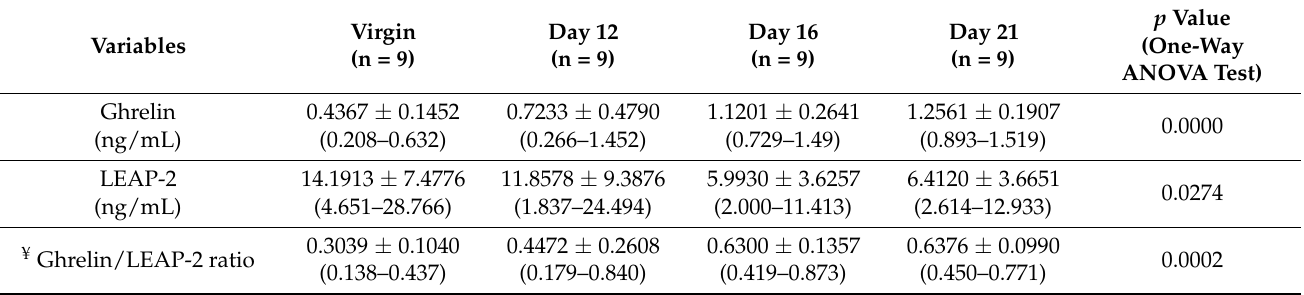
Table 2. Serum levels of ghrelin (ng/mL), LEAP-2 (ng/mL) and ¥ Ghrelin/LEAP-2 ratio in virgin and pregnant rats (Days 12, 16 and 21 of